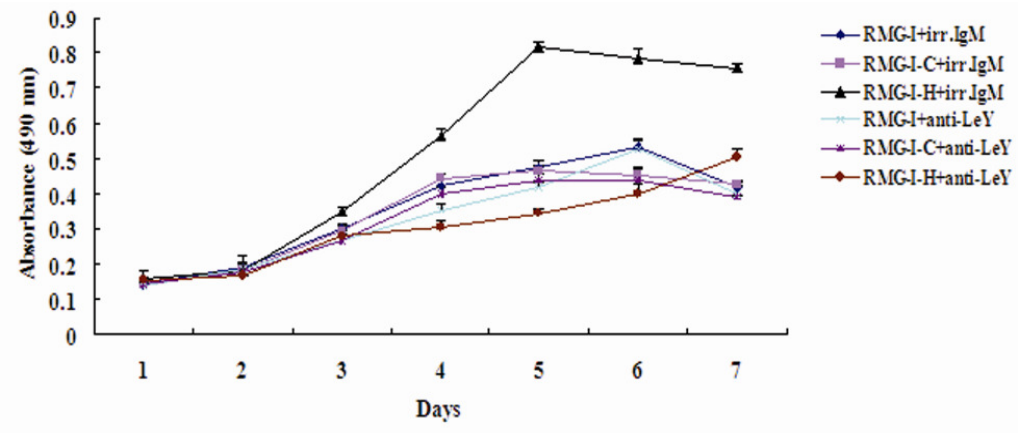
Figure 2. Cell proliferation was determined by the MTT assay. Cells treated with either anti-LeY mAb or control IgM antibody were incubated with MTT to perform cell growth analysis. Data are means ± SE from three individual